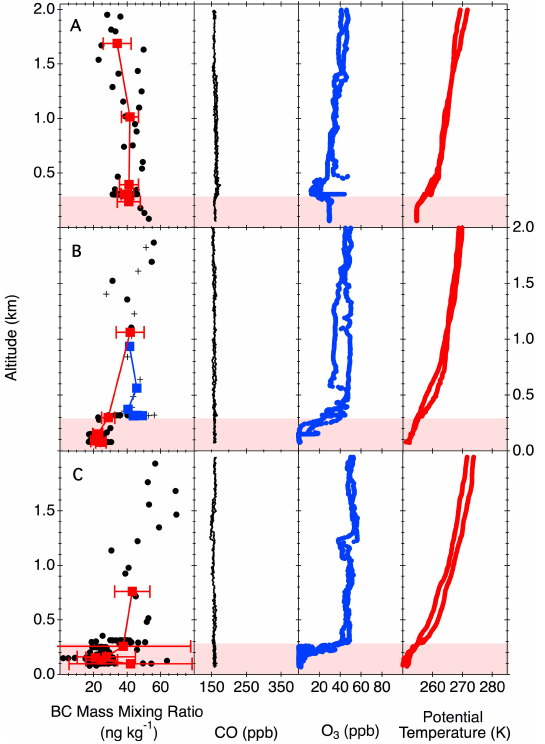
Fig. 6. Vertical profiles of BC mass, CO, O 3 , and potential temper- ature for the boundary layer flight segments on 12 April 2008 high- lighted in Fig. 5. The shaded regions mark the ABL. The profiles of BC mass consist of mean values of BC mass binned by altitude where each bin represents an equal fraction of the data. In (B) , the ascent (red line, circles) and descent data (blue line, plus markers) are segregated. The BC profiles consist of 30s data and the CO, O 3 , and potential temperature profiles are 1s